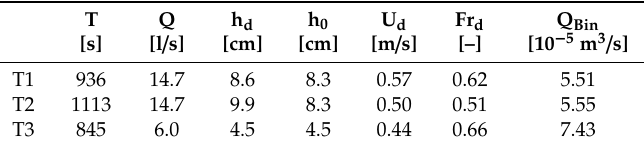
Table 1. Main parameters of the aggradation experiments.